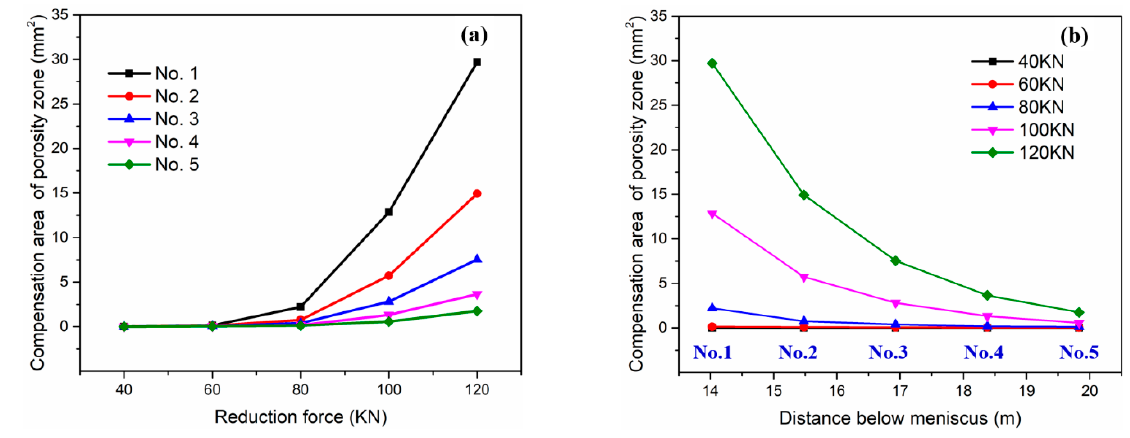
Figure 9. Ovality of round bloom after SR ( a ) different reduction forces, ( b ) different reduction positions.